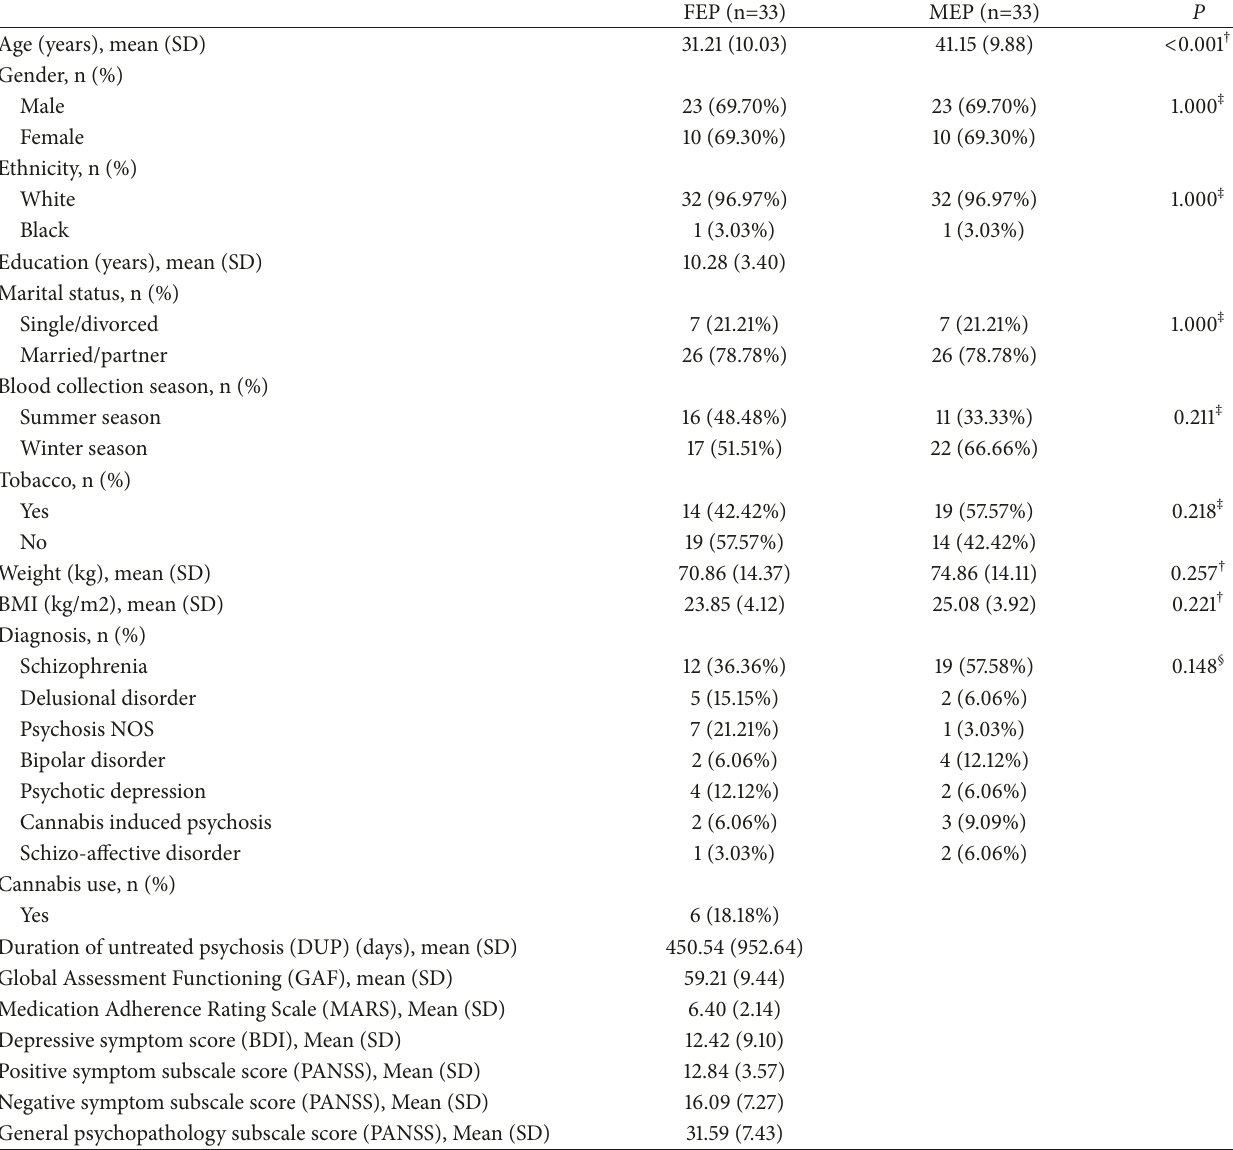
Table 1: Demographic and clinical characteristics of the study samples.